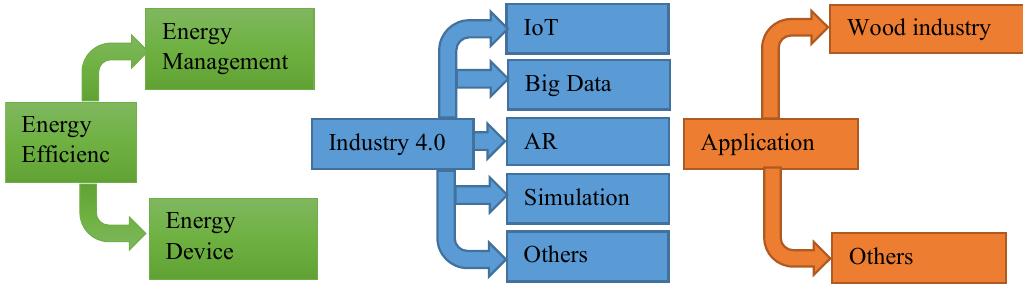
Figure 5. Dissecting diagram of energy efficiency, Industry 4.0, and wood industry.